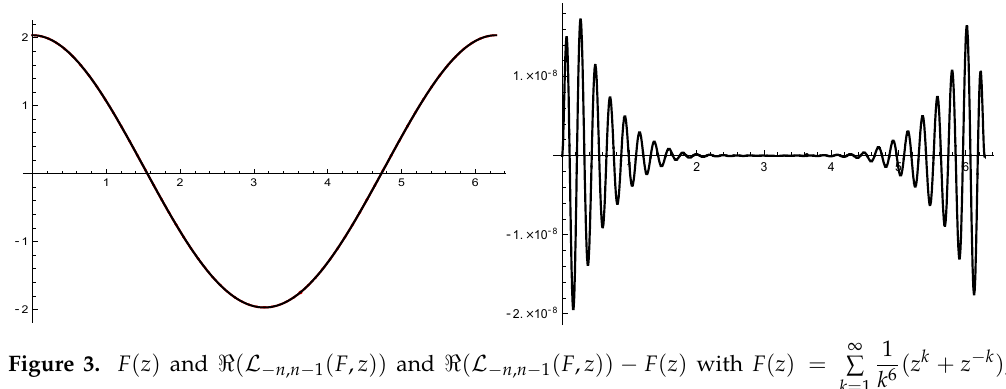
Figure 3. F ( z ) and (cid:60) ( L − n , n − 1 ( F , z )) and (cid:60) ( L − n , n − 1 ( F , z )) − F ( z ) with F ( z ) = z = e i θ , θ ∈ [ 0,2 π ] and n = 60.